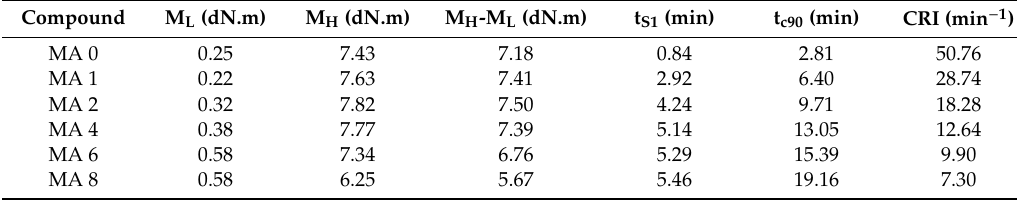
Table 3. Curing characteristics of NR / HNT and MNR / HNT composites.